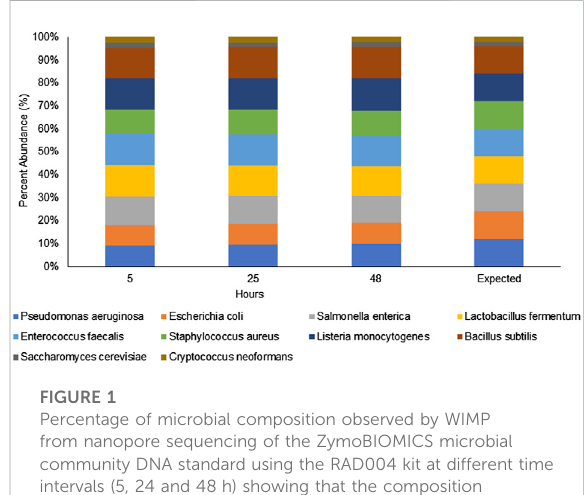
FIGURE 1 Percentage of microbial composition observed by WIMP from nanopore sequencing of the ZymoBIOMICS microbial community DNA standard using the RAD004 kit at different time intervals (5, 24 and 48 h) showing that the composition remained stable across those tested time frames and in a similar composition to the expected proportions.